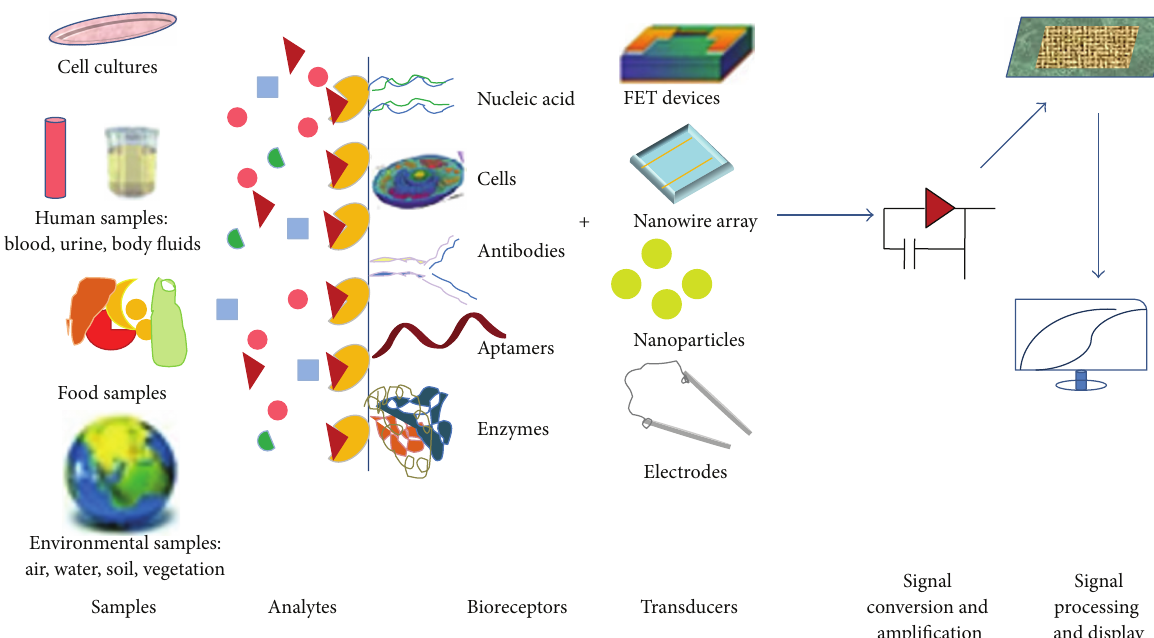
Figure 1: Schematic diagram showing the components of a biosensor. Reproduced after editing from Grieshaber